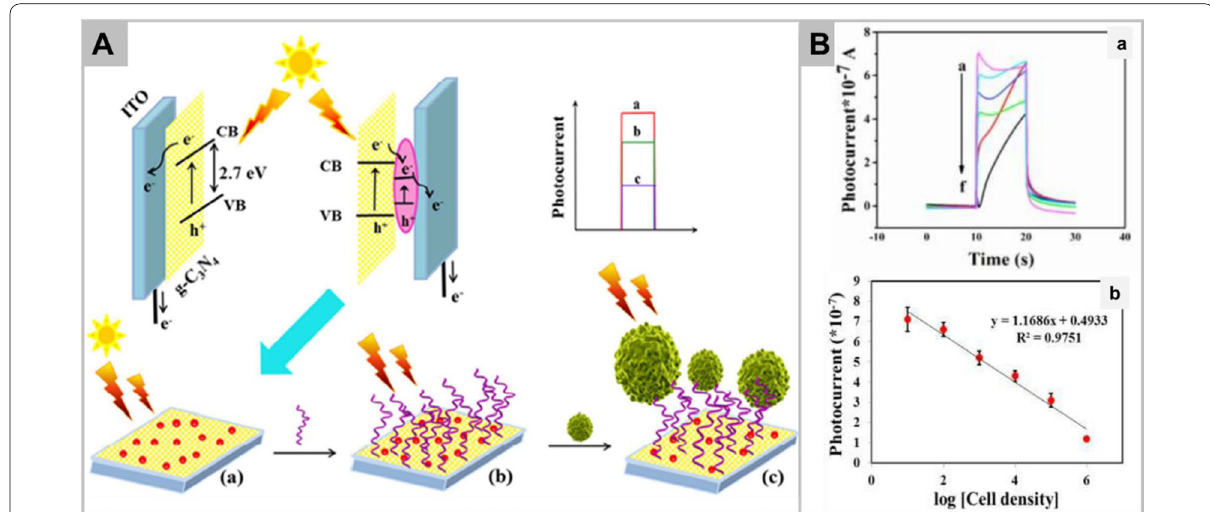
Fig. 6 Panel A illustrates PEC cytosensor fabrication process and its corresponding photocurrents. Panel B - a , Photocurrent responses of ITO/ C3N4-AgI/Aptamer after incubating with various concentrations of the Hela cells ( a ) 10, ( b ) 1 PBS (0.1 M, pH 7.4). Panel B - b , Calibration curve of the cytosensor for Hela cells detection; corresponding data points and error bars is related to the average and standard deviations from four individual experiments. Reprinted with permission from Journal of Material Chemistry B, Copyright 2018, Royal Society of Chemistry